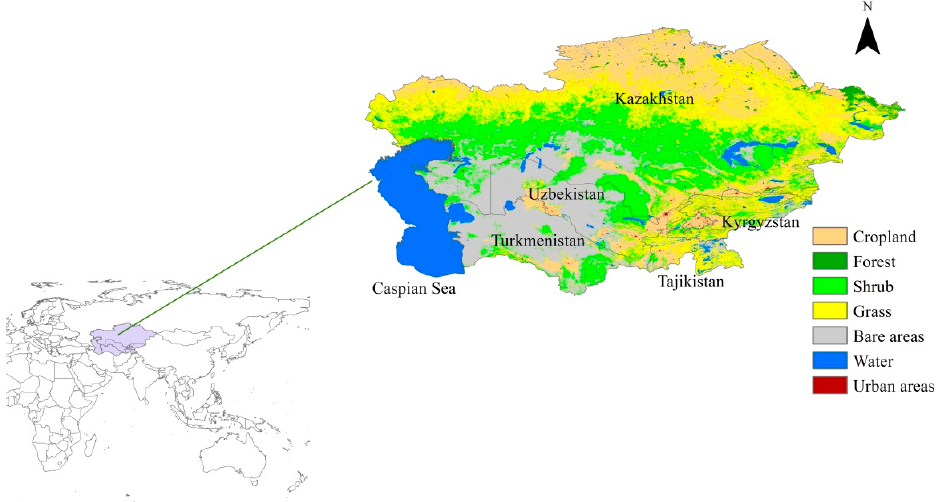
Figure 1. Location of the study area and vegetation types.